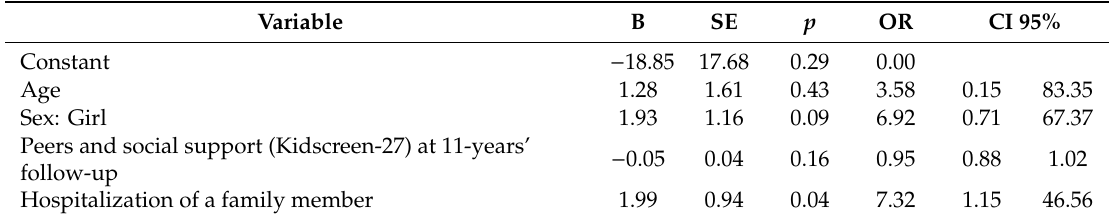
Table 5. Predictors of being a bully for the Gipuzkoa sample.